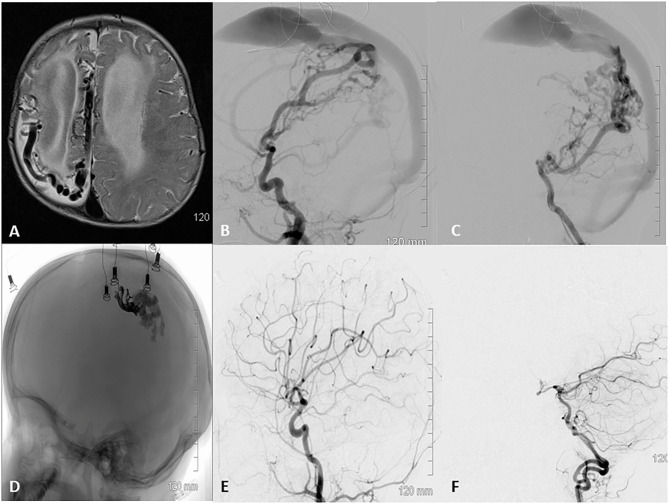
A 36 week old baby was diagnosed with a vascular malformation at 16 weeks of age. The mother noticed abnormal shape of the head with a bulge on the back of right side at 9 weeks and decreased movement of the left hand compared to the right at 16 weeks of age. The right side of the cranial vault is poorly developed, anterior fontanelle is open, full, and pulsating well. (A) MRI revealed numerous enlarged flow void in the midline and right hemisphere, with hydrocephalus and hemiatrophy on the right side of the brain. (B,C) DSA lateral view runs from the right common carotid and left vertebral revealed a pial AVF with arterial feeders arising primarily from the anterior and posterior branches of the right middle cerebral artery and the parieto-occipital branch of the posterior cerebral artery. The fistulas were multi holed and all were drained by a single enlarged venous channel that drained into the superior sagittal sinus. (D) Native lateral skull view demonstrating the final Onyx (darker anterior portion) and NBCA cast sealing several fistulae points over three staging embolization. (E,F) DSA 6 month follow up after last embolization show complete obliteration of the pial AVF with restoration of normal arterial phase.